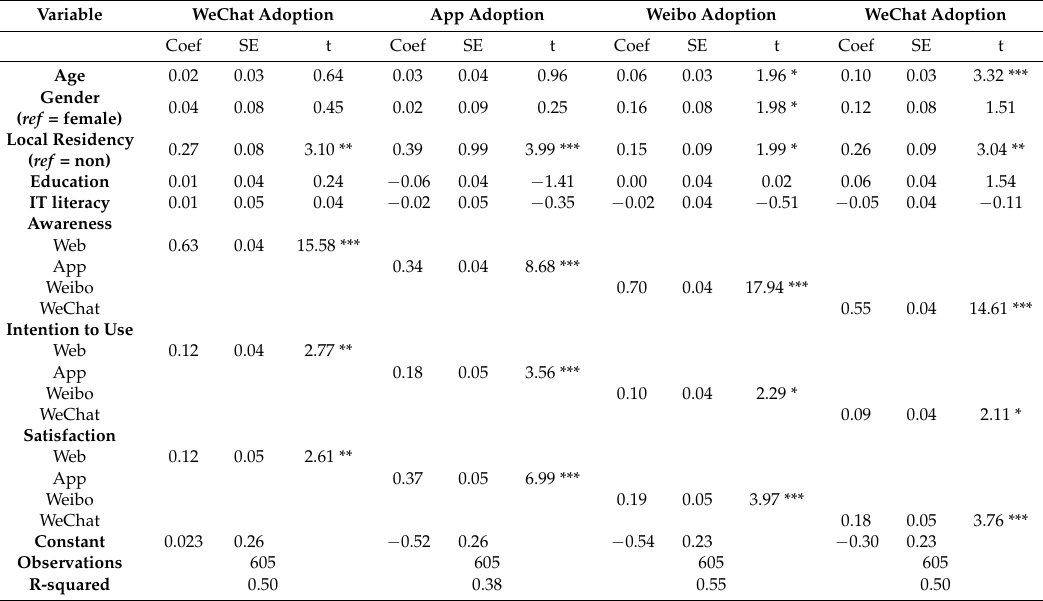
Table 2. Results of Regression Analysis on Determinants of Adoption of Four Local E-Services. Variable WeChat Adoption App Adoption Weibo Adoption WeChat